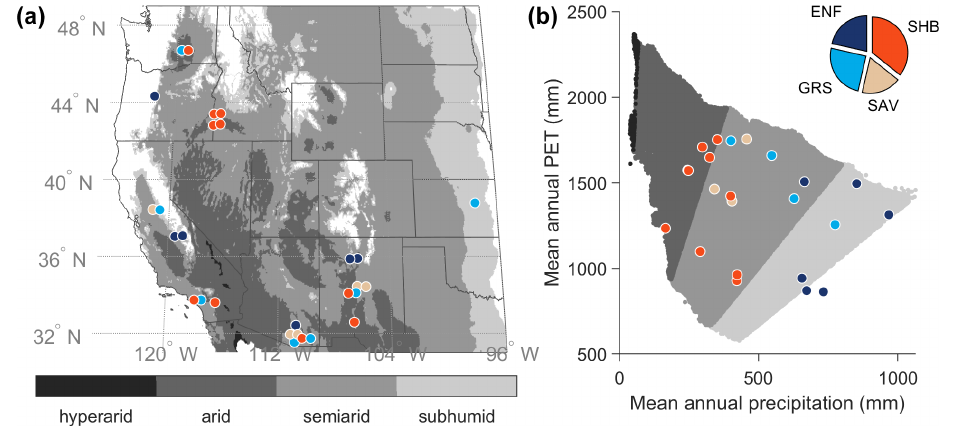
Figure 1. (a) Map of the geographic domain, aridity, and eddy covariance sites. Adjacent sites were slightly offset to improve visibility. (b) Climatic locations of the eddy covariance sites by mean annual precipitation ( P ) and potential evapotranspiration (PET). Grayscale background shows the P and PET distribution of all dryland grid cells shown in (a) , while the colored points show the distribution of the AmeriFlux sites in aridity space. (Note that some sites are not visible in b because their climates are essentially identical to adjacent sites, and their points therefore perfectly overlap.) Aridity classes were defined based on the ratio of mean annual precipitation to potential evapotranspiration (over 1981–2010) from the ∼ 4km TerraClimate dataset (Abatzoglou et al., 2018): subhumid (0.5 ≤ P/ PET ≤ 0.75), semiarid (0.2 ≤ P/ PET < 0.5), arid (0.03 ≤ P/ PET < 0.2), and hyperarid ( P/ PET < 0.03). Sites are color coded by vegetation type (shown in the pie chart in b ): evergreen needleleaf forest (ENF), grassland (GRS), shrubland (SHB), and savanna (SAV). Site details can be found in